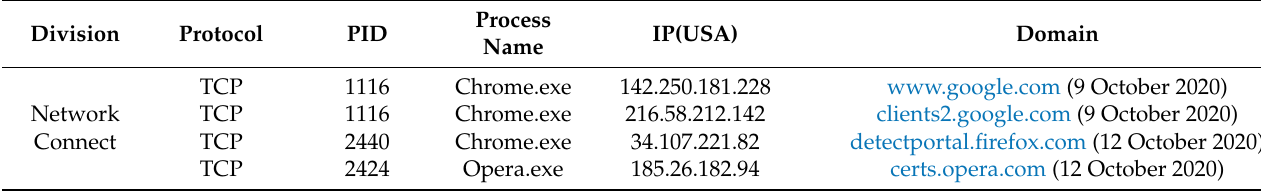
Table 7. Network connection packet analysis results.